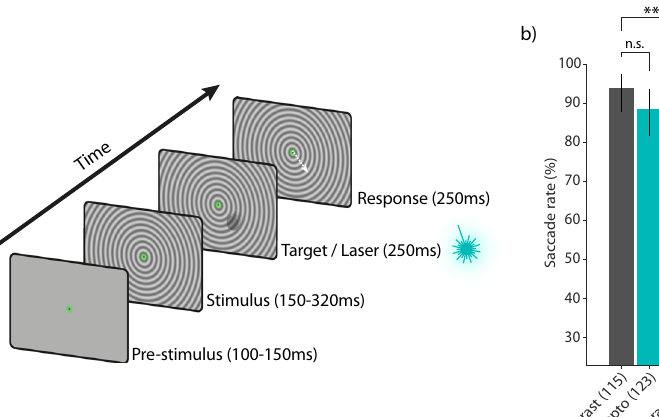
contrast targets were paired with optogenetic stimulation (55.9% vs. 81.7%; n =118 and n =109 trials, respectively; two-sided Chi-squared test; P =1.47e-04).